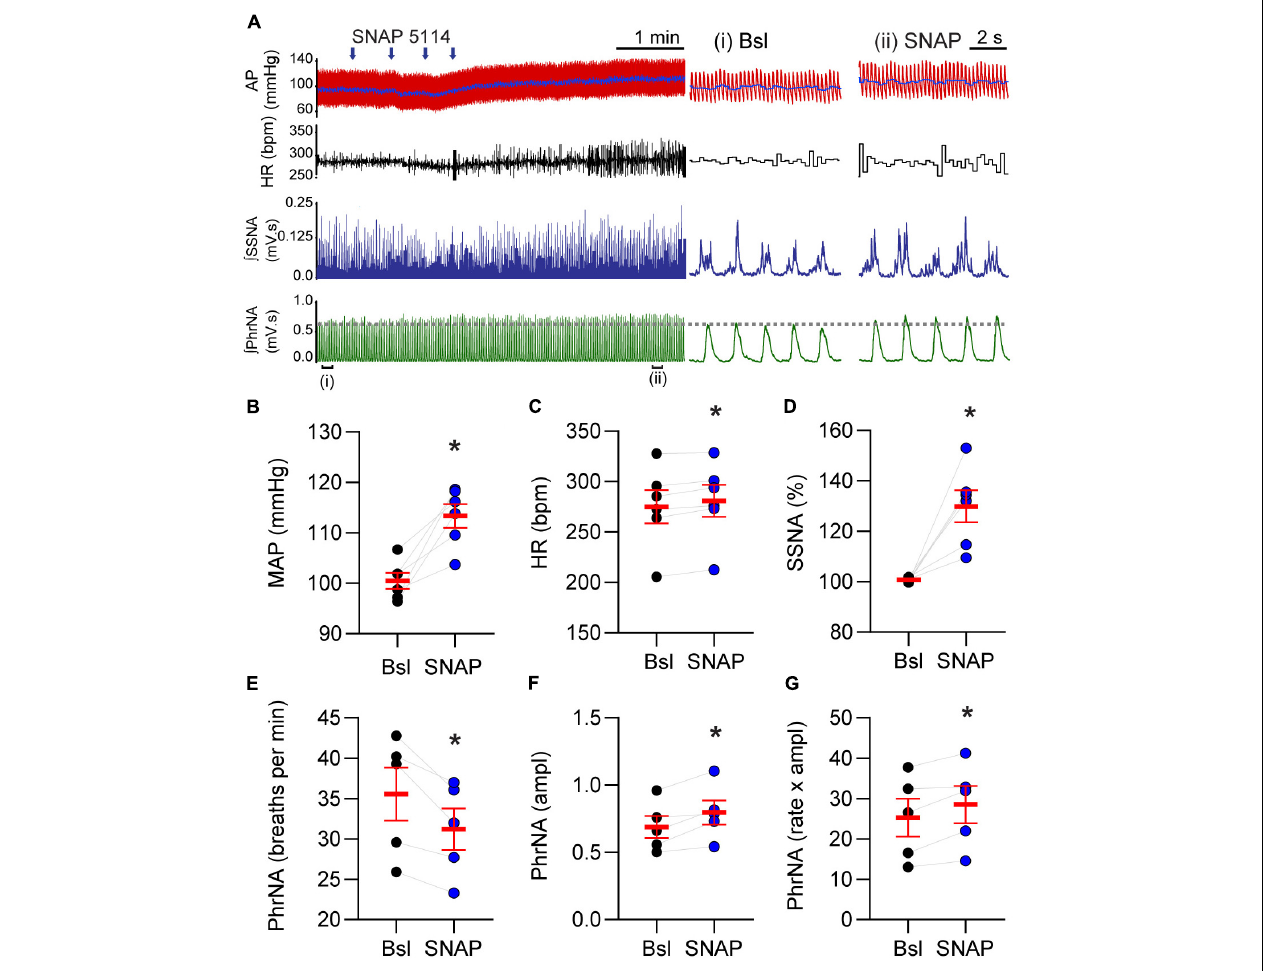
FIGURE 6 | Gamma-aminobutyric acid transporters prevent increases in blood pressure, heart rate, sympathetic nerve activity and phrenic nerve discharge. (A) Left : Example of cardiorespiratory response to nTS nanoinjection (arrows indicate four unique injection sites within the nTS over time) of SNAP 5114 (1 mM). Right : Expanded time traces showing pre-injection (control) and ∼ 5 min post SNAP injection (denoted by brackets below left trace). Note the increase in cardiorespiratory parameters. Injection of vehicle controls had no effect on parameters (not shown). (B–G) Group data showing SNAP 5114 significantly increases MAP, HR, SSNA, phrenic amplitude and minute phrenic activity. Phrenic frequency significantly decreased. MAP, HR, SSNA: N = 6; PhrNA, N = 5, paired t -test. Data in (B–G) are shown as individual neurons (connected circles), their responses, and means ± SEM in red. * p ≤ 0.05 vs baseline